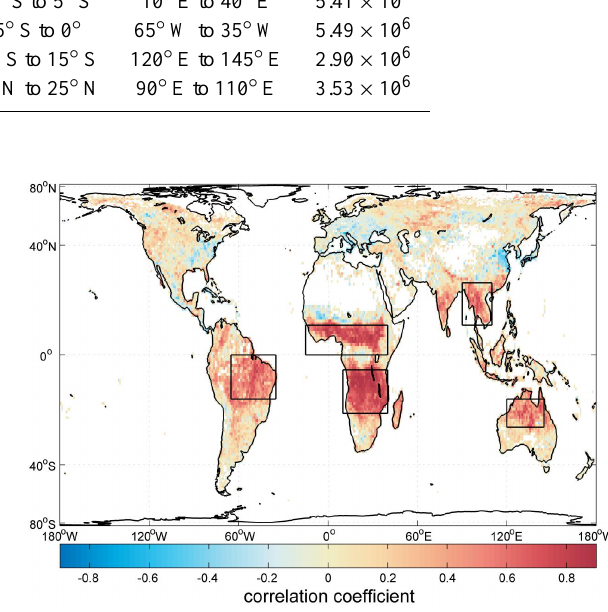
Figure 2. Correlation coefficients (r) of the local temporal relationship between FRP and TVC 2 Fig. 2. Correlation coefficients ( r ) of the local temporal relationship NO 2 based on monthly averages from 2007-2011 on a 1° x 1° grid. Data are shown for the linear 3 between FRP and TVC NO 2 based on monthly averages from 2007 relationship observed between GOME-2 TVC NO 2 and MODIS Terra FRP. 4 to 2011 on a 1 ◦ × 1 ◦ grid. Data are shown for the linear relationship observed between GOME-2 TVC NO 2 and MODIS Terra